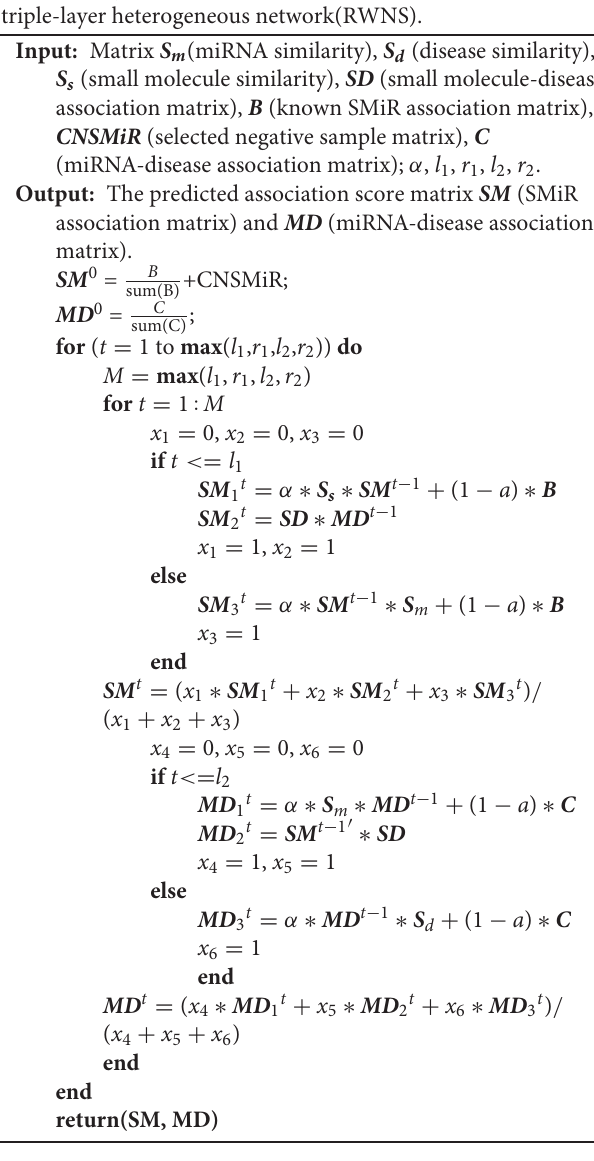
Algorithm 2: Identifying SMiR associations based on a credible negative sample selection and random walk